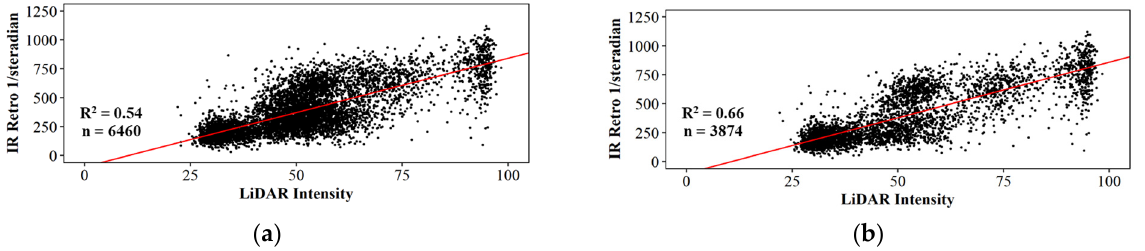
Figure 12. Center skip line linear correlation of LiDAR intensity and infrared retroreflectivity: ( a ) US-52 and US-41 combined linear correlation of LiDAR intensity and infrared retroreflectivity and ( b ) US-41 linear correlation of LiDAR intensity and infrared retroreflectivity.